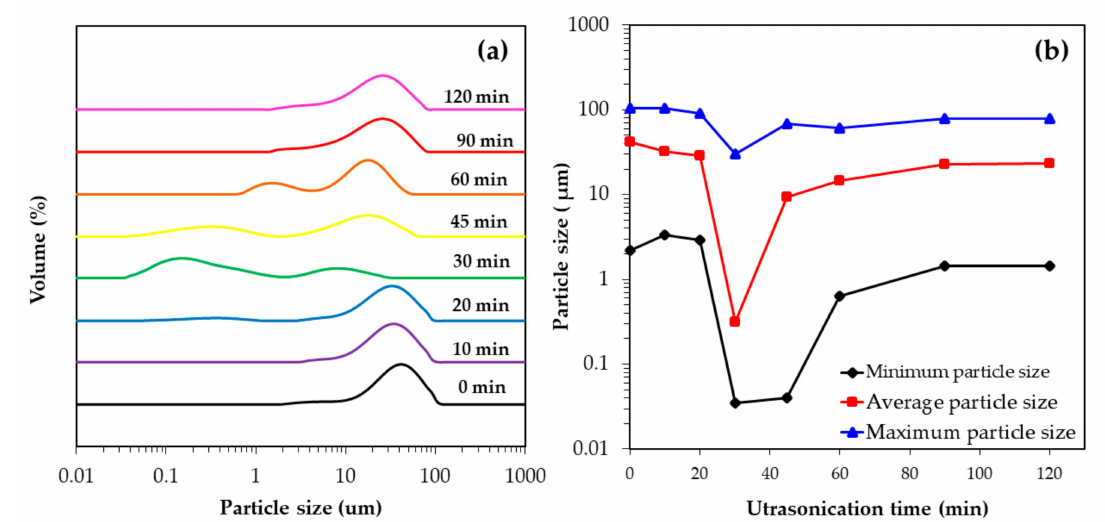
Figure 3. Change in particle size of the 3M NaOH treated OPA suspension before different ultrasonication times: ( a ) particle size distribution and ( b ) the maximum particle size, average particle size and minimum particle size of treated